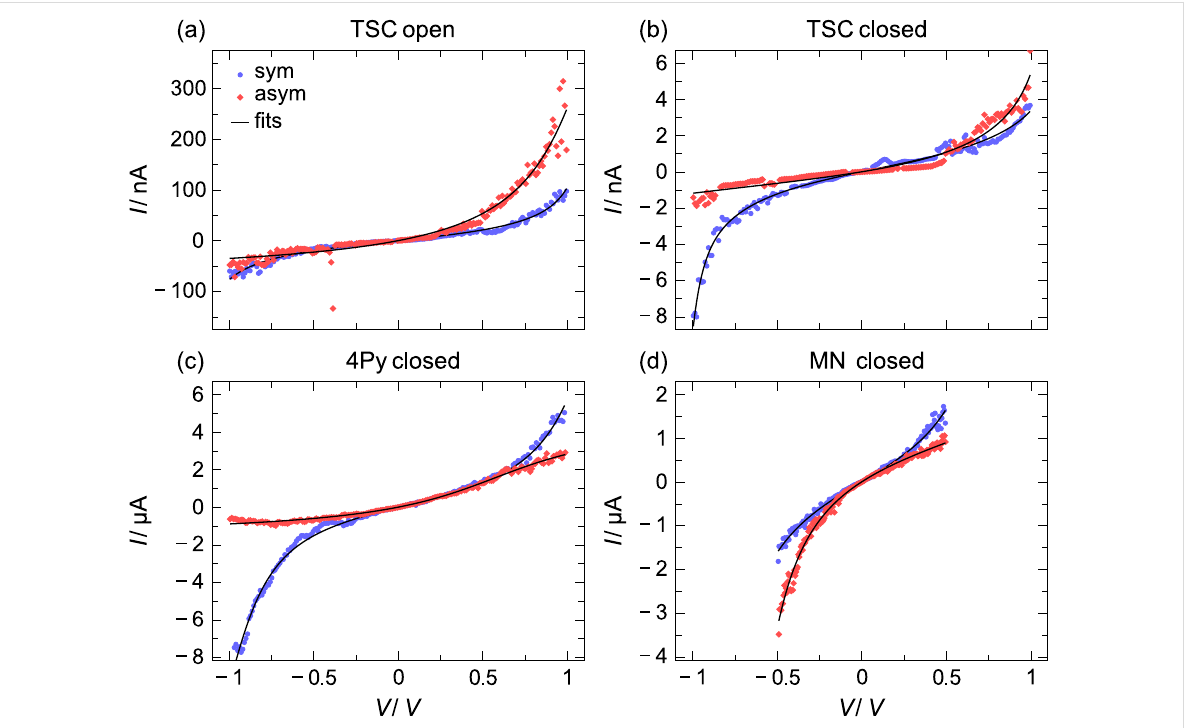
Figure 2: Examples of I – V characteristics of open and closed isomers. (a) Open form of TSC, (b) closed form of TSC. (c) Closed form of 4Py, (d) closed form of MN. The colored curves are experimental data, and the black curves are the fits to Equation